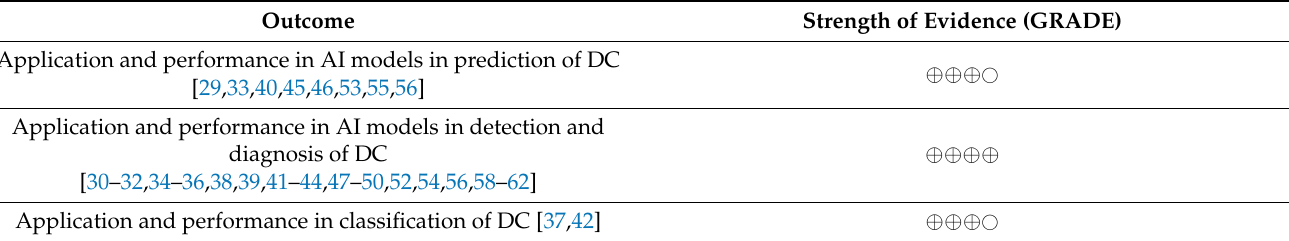
Table 3. Assessment of Strength of Evidence. Outcome Strength of Evidence